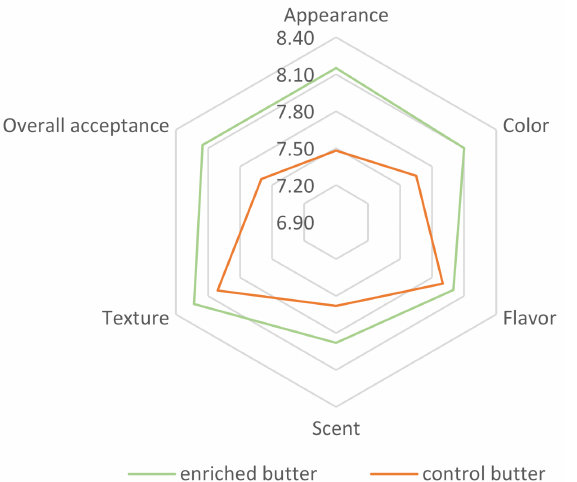
Figure 8. Sensory analysis for control (non-enriched) and enriched butter with H. portulacoides